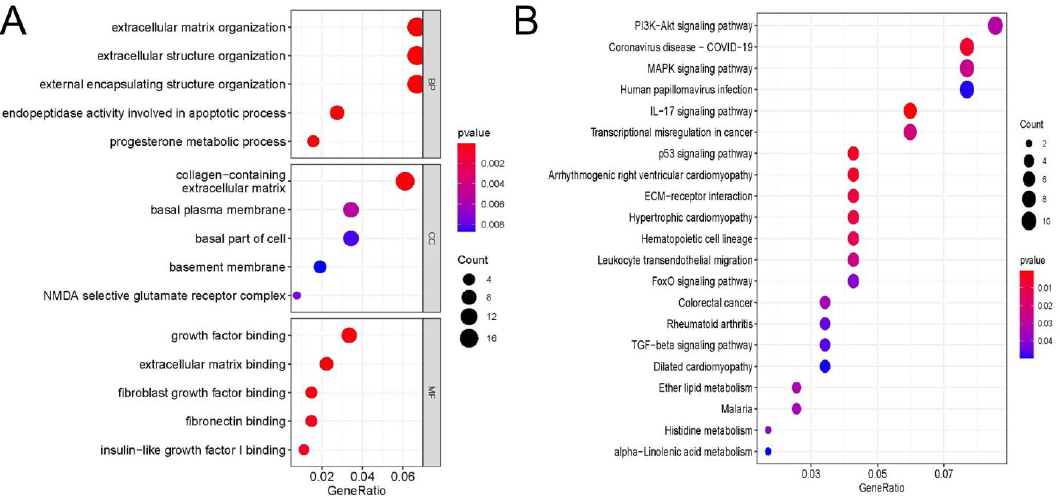
Figure 5. GO and KEGG analyses of differentially expressed genes: ( A ) Major Gene Ontology terms were significantly enriched for the differentially expressed genes. ( B ) The top 20 significantly enriched pathways for the differentially expressed genes.